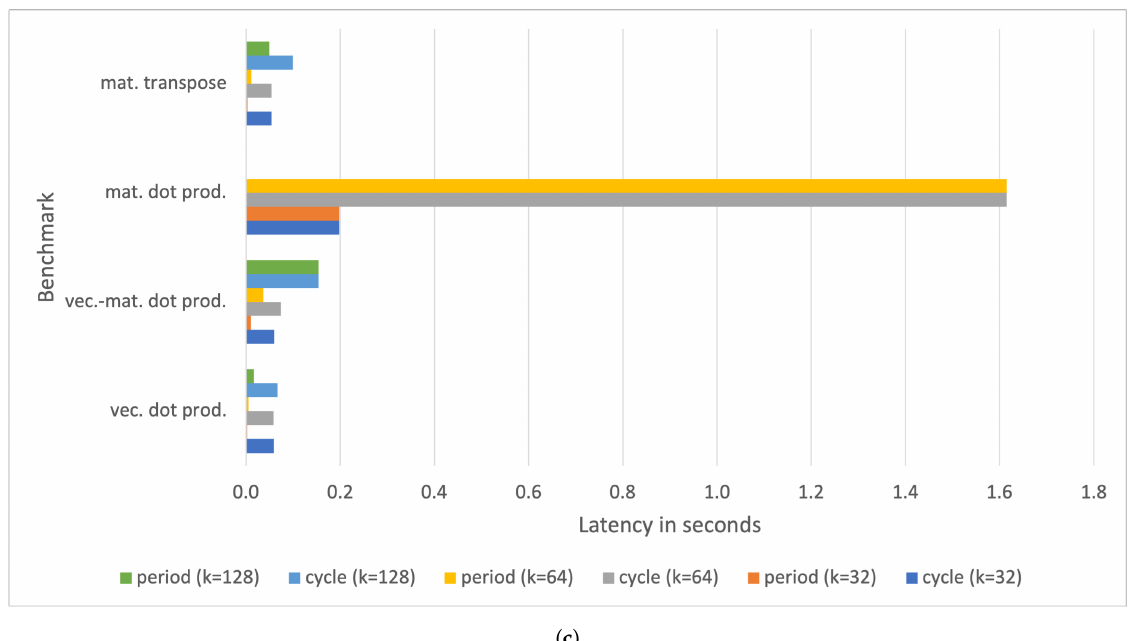
( c ) Figure 10. Measured period and cycle parameters with k ∈ { 32,64,128 } on a Raspberry Pi IV for ( a ) rank 1 tensor operations, ( b ) rank 2 tensor operations, and ( c ) typical vector and matrix operations.